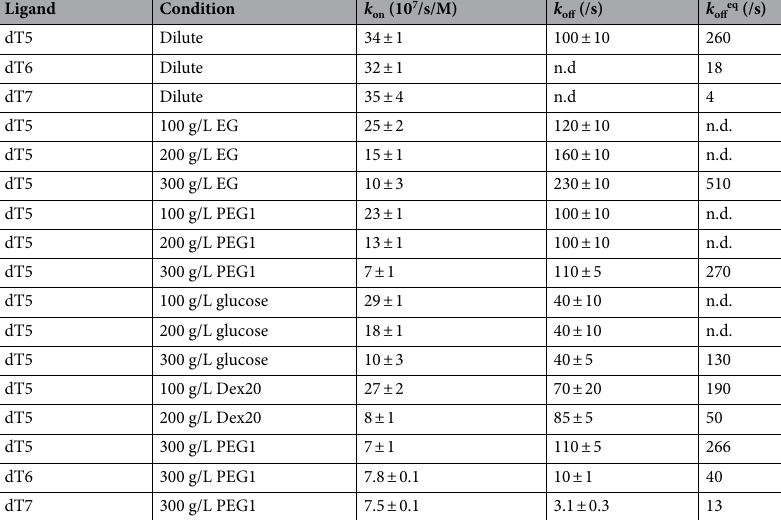
Table 2. Numerical values reporting on the association rate constant, k on , and the dissociation rate constant, k off , quantifying the interaction between different oligonucleotides and Bs CspB obtained under dilute conditions and in crowded environments determined by kinetic stopped-flow fluorescence spectroscopy. The value of k off eq has been calculated by applying k off eq = K D * k on (see Table 1 reporting on K D values). The concentration of Bs CspB was set to 60 nM in all experiments except in presence of 300 g/L EG ( c Bs CspB = 300 nM). A 5- to 20-fold stoichiometric excess of ligand concerning Bs CspB has been used in all kinetic stopped-flow fluorescence experiments which have been performed at T = 288 K. n.d.: not determined. Associated data are shown in Figs. 3A–D, S7A,B, and